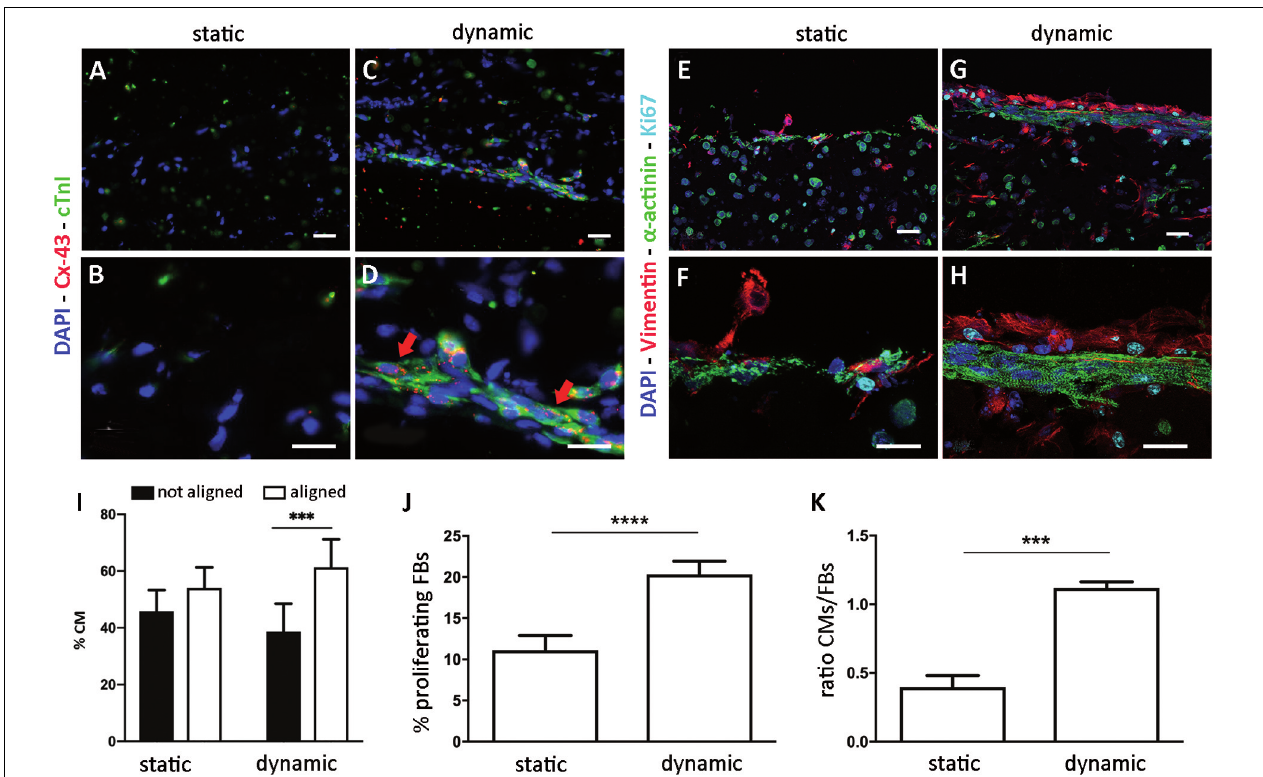
FIGURE 4 | ECT biological characterization. Representative immunofluorescence images of statically (A,B,E,F) and dynamically (C,D,G,H) cultured ECTs at low ( A,C,E,G , scale bar = 30 µ m) and high ( B , D , F , H , scale bar = 10 µ m) magnification, stained for cardiac markers connexin-43 (Cx-43, red), Troponin I (cTnI, green), and α -sarcomeric actinin ( α -actinin, green); for FB marker Vimentin (red); and for proliferating marker Ki67 (cyan). Nuclei are stained with DAPI (blue). (I) Graph showing the percentage of CMs aligned and not aligned with the direction of the mechanical stimulation, for statically ( n = 3) and dynamically ( n = 4) cultured ECTs. (J) Graph showing the percentage of proliferating FBs in statically and dynamically cultured ECTs at day 9. (K) Graph showing the ratio of CMs and FBs in statically and dynamically cultured ECTs at day 9. For all groups, n = 3, ∗∗∗ p ≤ 0.001; ∗∗∗∗ p ≤